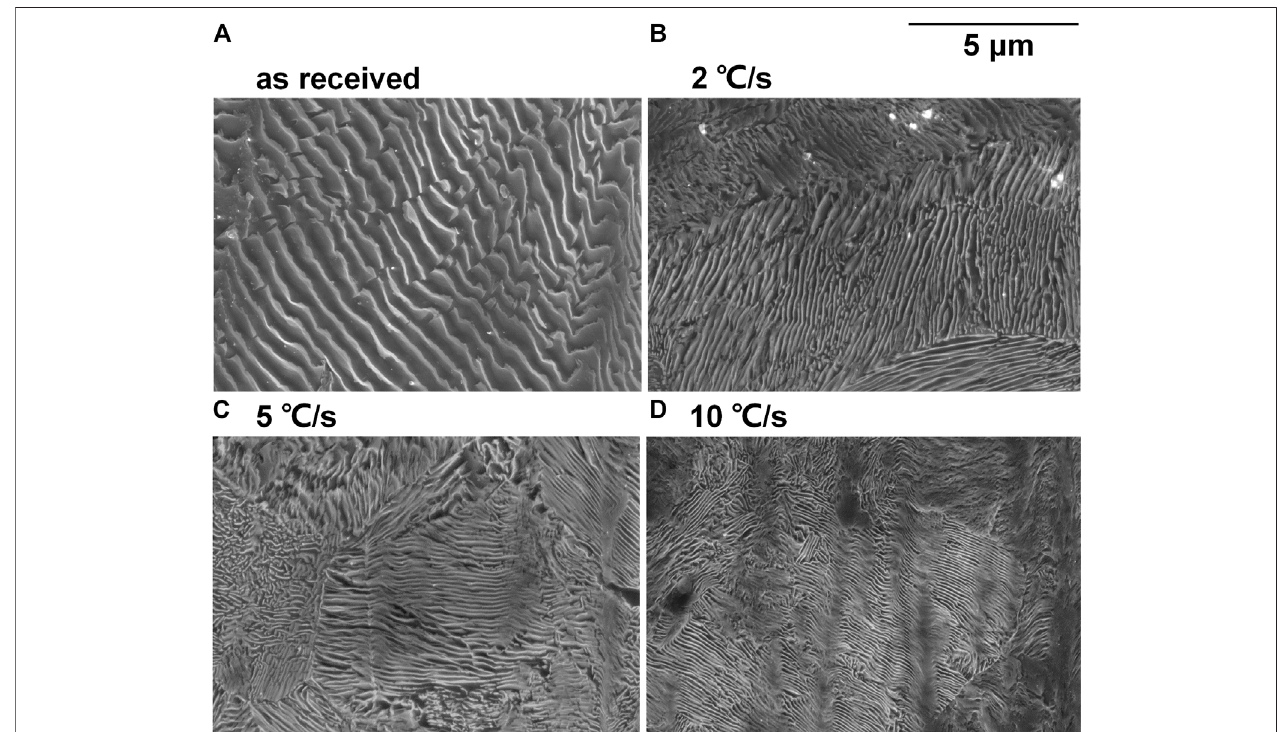
FIGURE2| SEMmicrographsoftheetchedsurfaceofthe (A) as-receivedsampleandthesamplesafterheattreatmentwithcoolingrates (B) 2 ° C/s, (C) 5 ° C/s,and (D) 10 ° C/s.